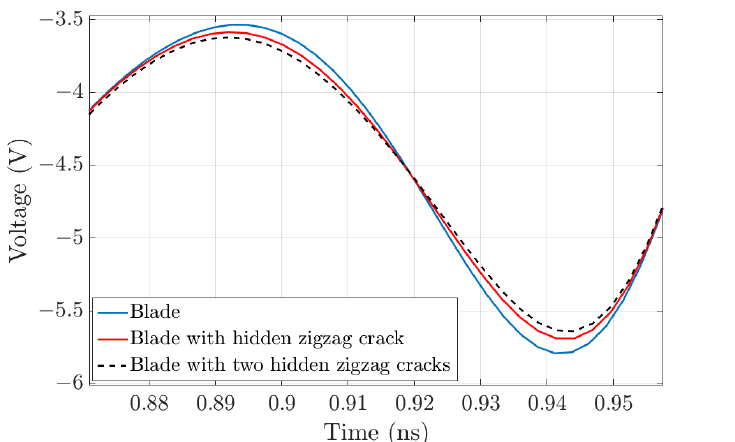
Figure 21. The difference in the amount of reflected voltage between the blades without cracks and those with one invisible zigzag crack and two